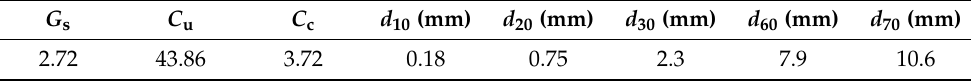
Figure 4. Soil used for dam models. ( a ) Photographs of each particle group. ( b ) Particle size distribution. Table 2. Geometrical and mechanical properties of soil used for dam model preparation.